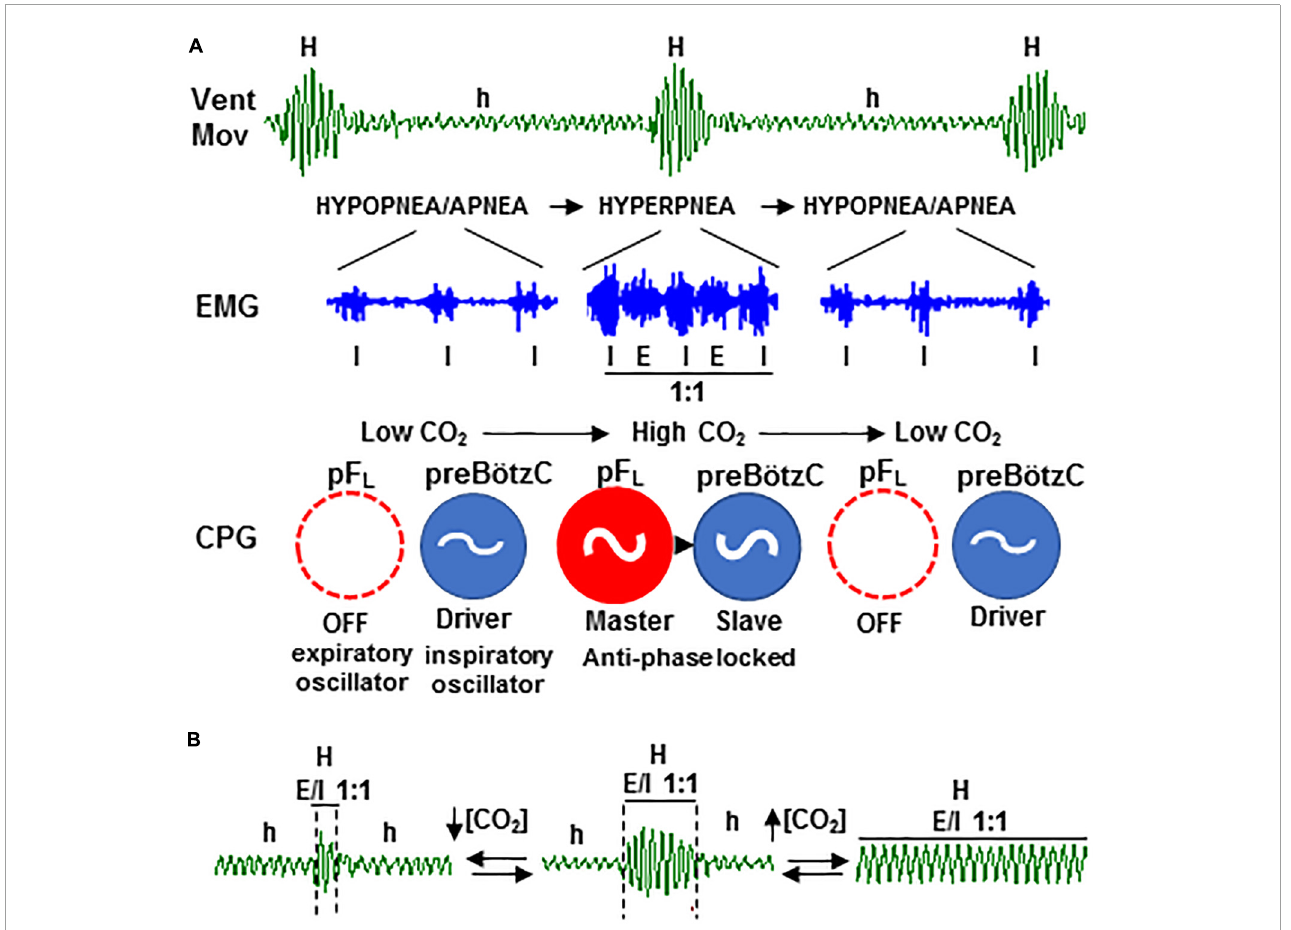
FIGURE9 Rhythmogenic mechanism of periodic Cheyne–Stokes breathing based on the two-oscillator system. (A) Self-sustained hypopnea-hyperpnea alternation in CSB ( Vent ; h and H ) results from the recurrent reconfiguration of the respiratory motor pattern ( EMG ) between an inspiratory-driven rhythm of low motor activity ( I ) during the hypopnea epochs and an expiratory and inspiratory rhythm coupled in a ratio of 1:1 ( E/I 1:1) during hyperpnea epochs, denoting the cyclic turn on/off of the expiratory pF L oscillator of central pattern generator ( CPG , in red); expiratory oscillator acts as an “anti-apnea” pacemaker that entrains inspiratory preBötzC oscillator (in blue) for rescuing its disability to sustain ventilation. (B) Coupling between the expiratory and inspiratory oscillators is CO 2 -dependent; PaCO 2 increase above the apneic threshold suppresses CSB by stabilizing expiratory–inspiratory coupling (right) while PaCO 2 reduction diminishes to the minimum the number of breathing cycles that expiratory–inspiratory coupling lasts